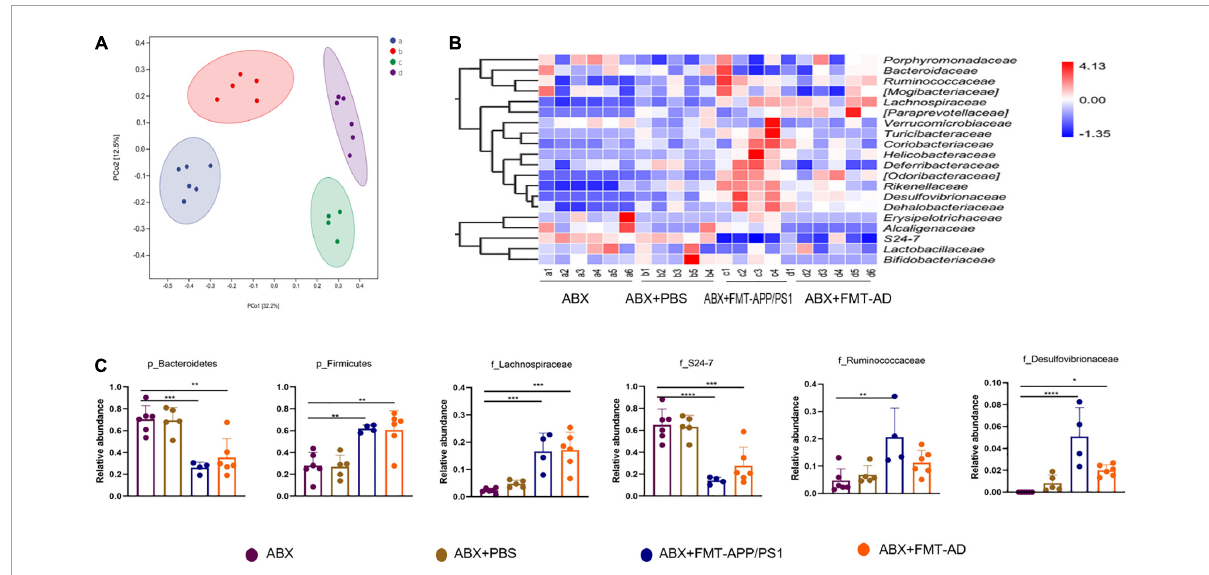
FIGURE3 Alterations in the gut microbiota of wild-type (WT) recipient mice after fecal microbiota transplantation (FMT). (A) Principal coordinates analysis (PCoA) plots based on unweighted UniFrac distances. (B) Alterations in relative abundance (RA) of gut microbiota based on the heatmap. (C) RA bar plots of gut microbiota between groups at the phylum and family levels. P < 0.05 was set as the threshold for significance by one-way ANOVA followed by post-hoc comparisons using LSD’s test for multiple groups’ comparisons, * p < 0.05, ** p < 0.01, *** p < 0.001, and **** p <